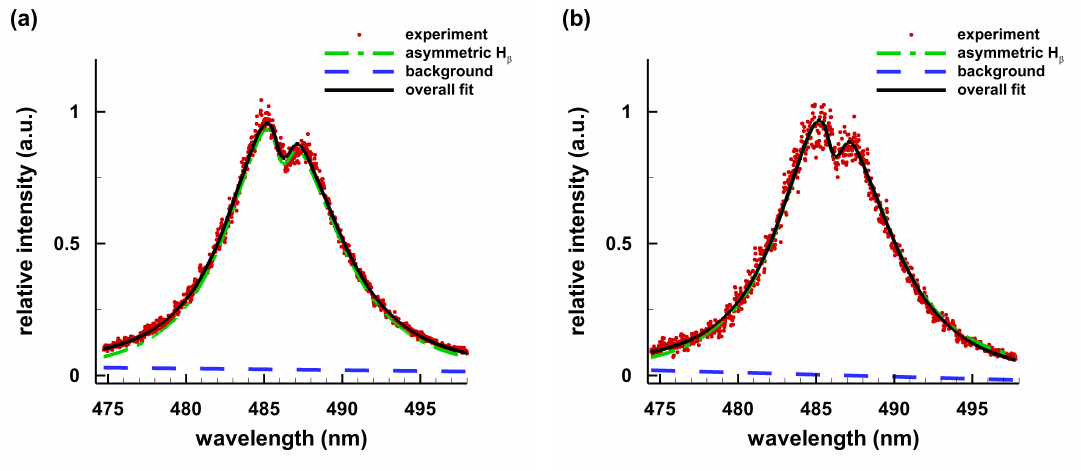
Figure 1. H β spectra for τ = 400 ns and inferred electron densities of 2.3 × 10 17 cm − 3 : ( a ) line-of-sight at the vertical center of the 4-mm plasma; and ( b ) Abel-inverted spectrum 0.5 mm from the horizontal center [23].